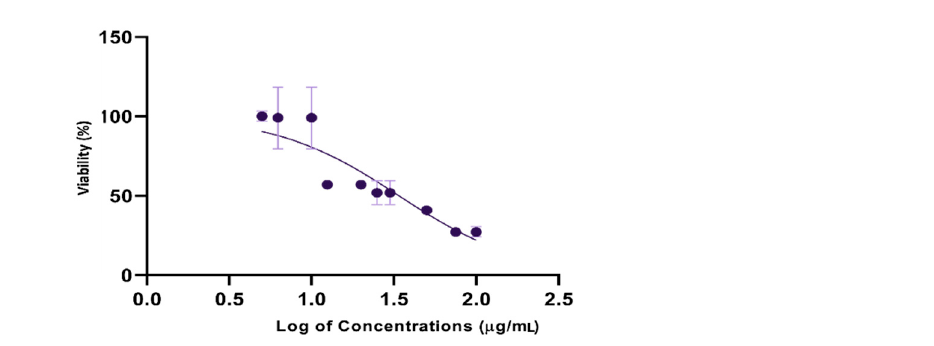
Table 1. GC-MS analysis results of Opophytum forsskalii and arabic Gum